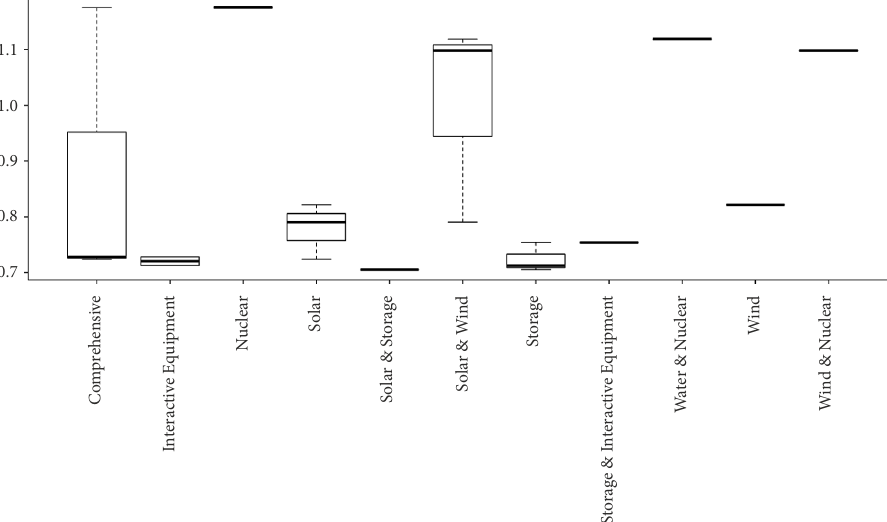
Figure 6. The distance distribution between different nodes in sub-sector